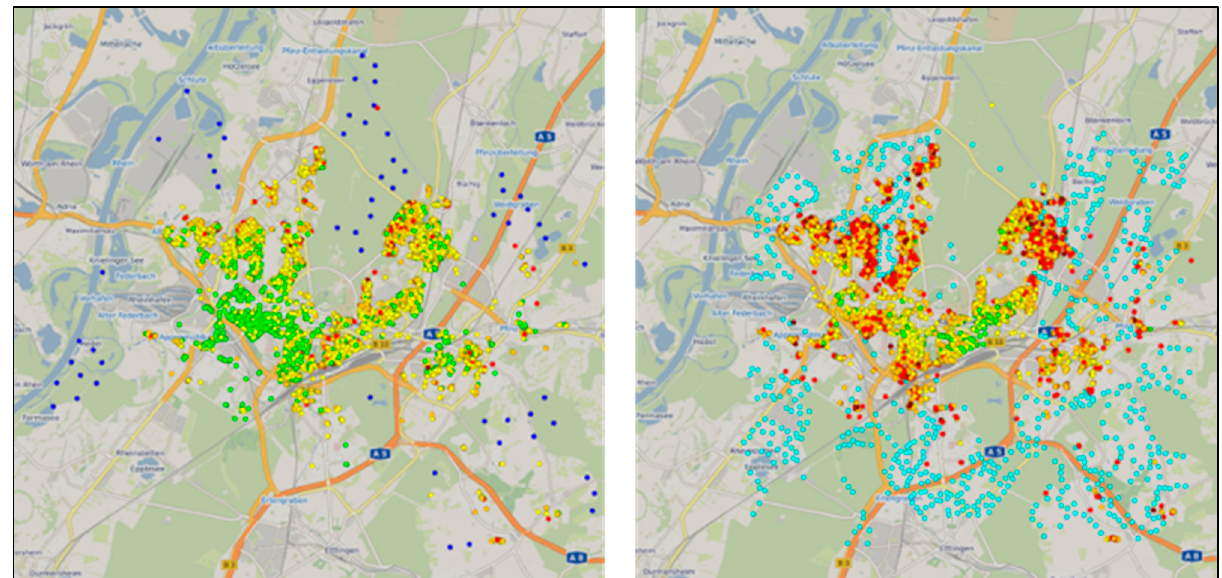
Figure 4. Deviations and discrepancies in citizens’ attitudes towards wind turbines ( left ) and pho- tovoltaic plants ( right ) between the first local and global surveys. Values range from 1 (green; no discrepancy) to 5 (dark red; strongest discrepancy). The blue dots in the left-hand image are wind turbine locations, and the cyan dots in the right-hand image are photovoltaic plant locations. In both images, the tendency of citizens to change their opinion if they are personally affected becomes visible, caused by the proximity of entities.